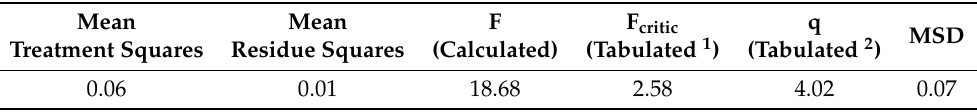
Table 11. ANOVA and Tukey’s test parameters for Poisson’s ratio. Mean Treatment